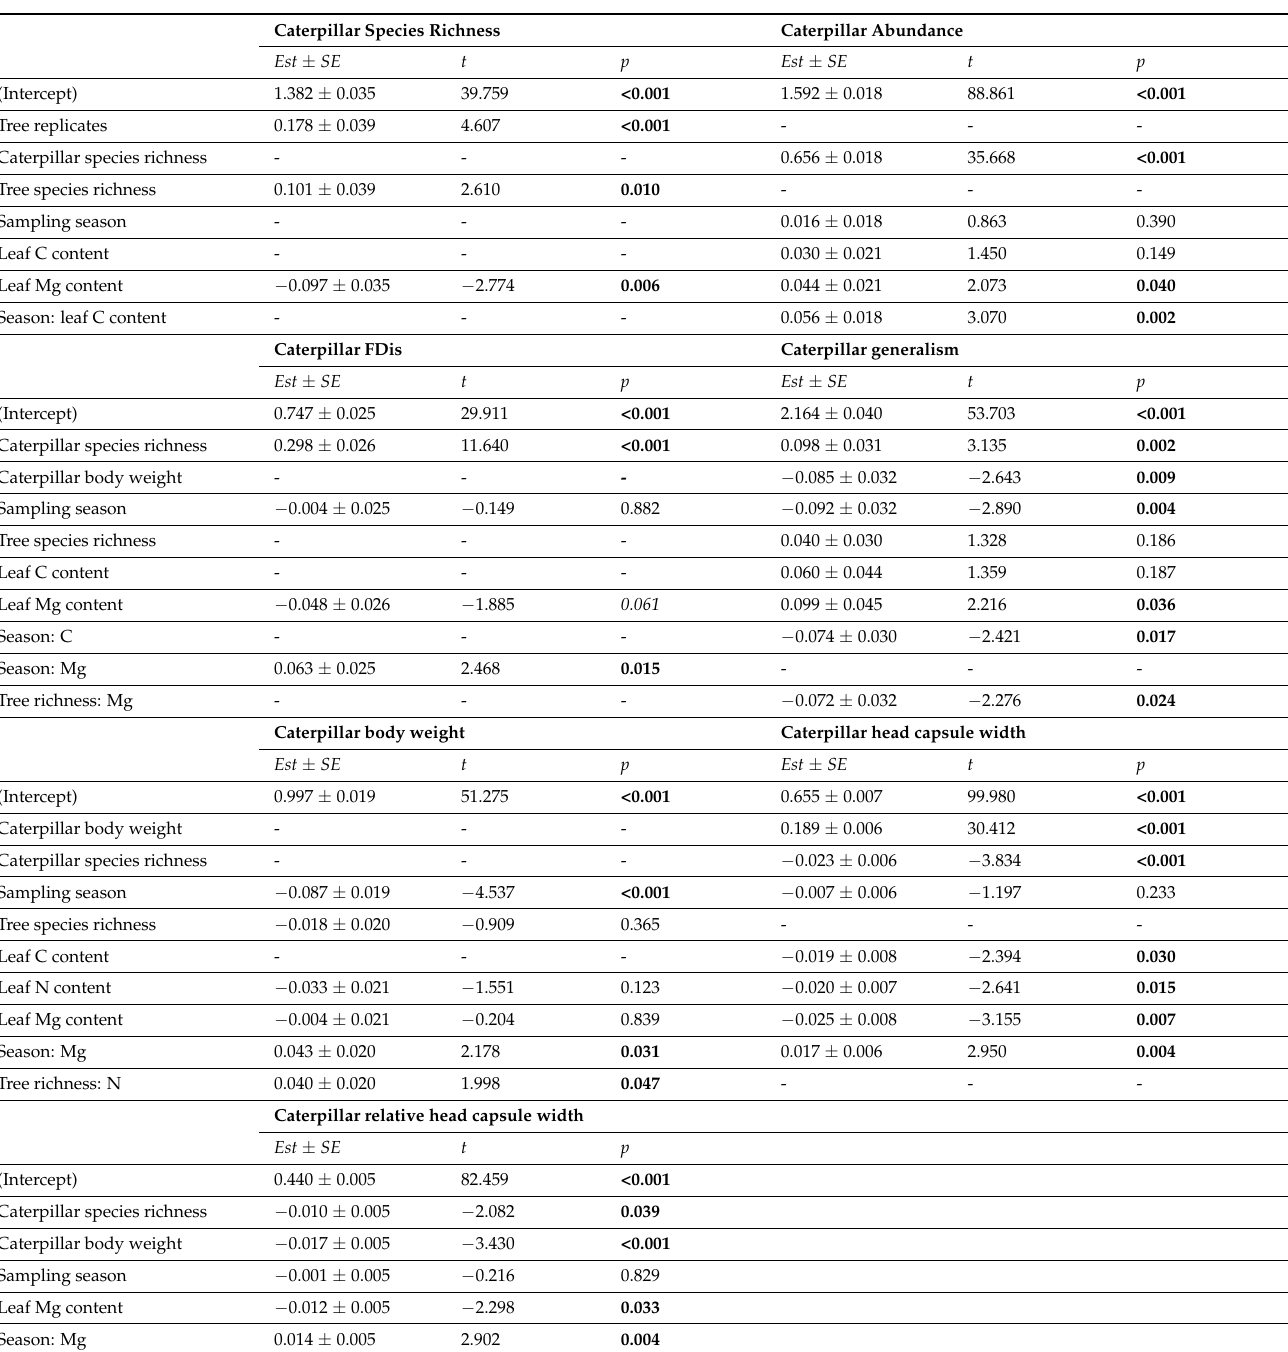
Table 1. Summary results of linear mixed-effects models after fixed factor reduction using backward selection with criterion p < 0.05 for the averaged caterpillar traits per tree species per richness level per season. All factors are scaled by subtracting the mean and dividing by standard deviation. All variables except tree replicates, sampling season, and tree richness are log + 1 transformed. Body weight values are also cube root transformed. Standardized parameter estimates (with standard errors, t and p values) are shown for the variables retained in the minimal models. p -values in bold mean p ≤ 0.05, p -values of italic mean p ≤